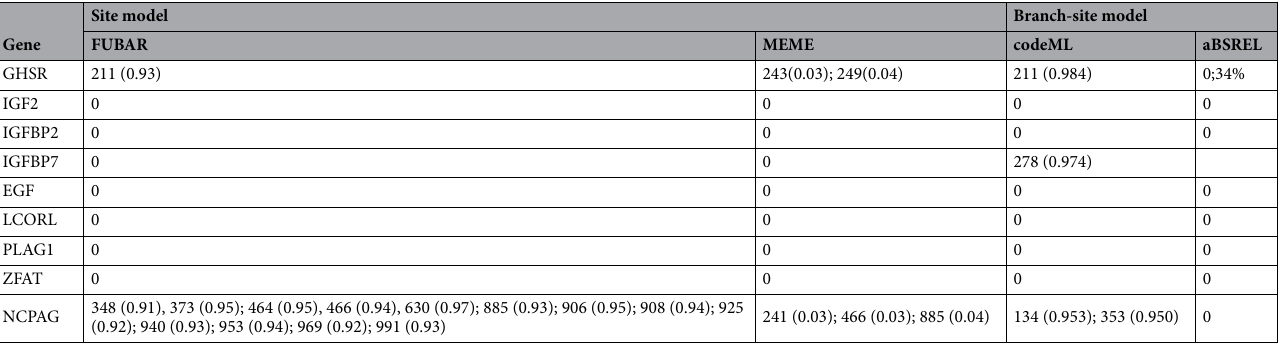
Table 1. Codon positions under positive selection detected by the site model using FUBAR and MEME using genes trees. Significance was assessed by Posterior Probability (PP) > 90% in FUBAR and p value < 0.05 in MEME. Detection of the position of codons under positive selection was carried out through the branch-site model using codeML and aBSREL. Significance is obtained through BEB (Posterior Probability (PP) > 0.90) for codeML and p -value < 0.05 in